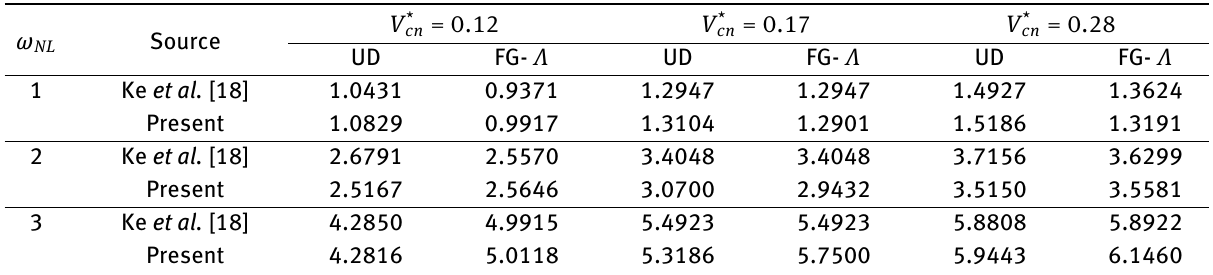
Table 3: Comparison of first three non-dimensional natural frequencies of UD and FG- Λ CNTRC beams at T = 300 K. The geometric parame- ter are taken to be a / h = 12, h = 0.1